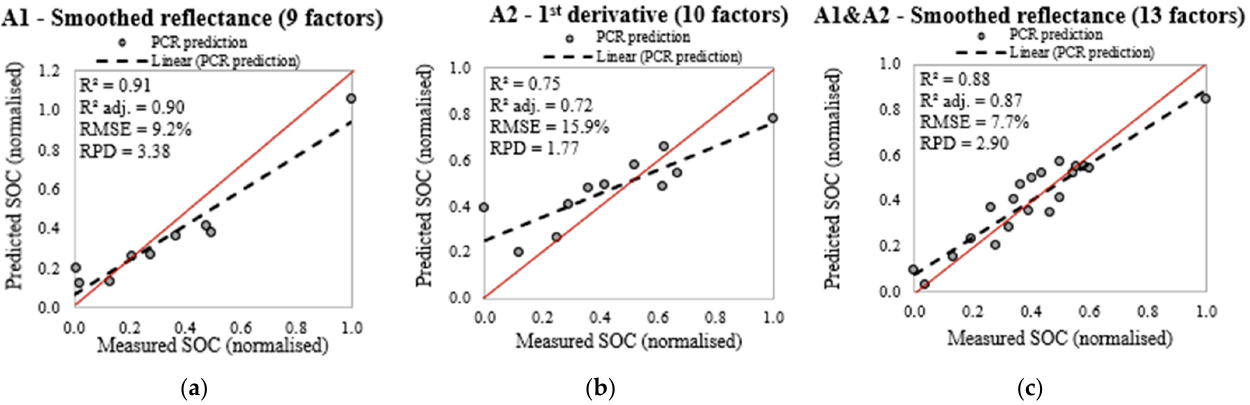
Figure 13. Validation results of the PCR models for SOC prediction after selecting the spectral bands, for ( a ) smoothed reflectance—A1, ( b ) first derivative—A2, and ( c ) smoothed reflectance—A1&A2.